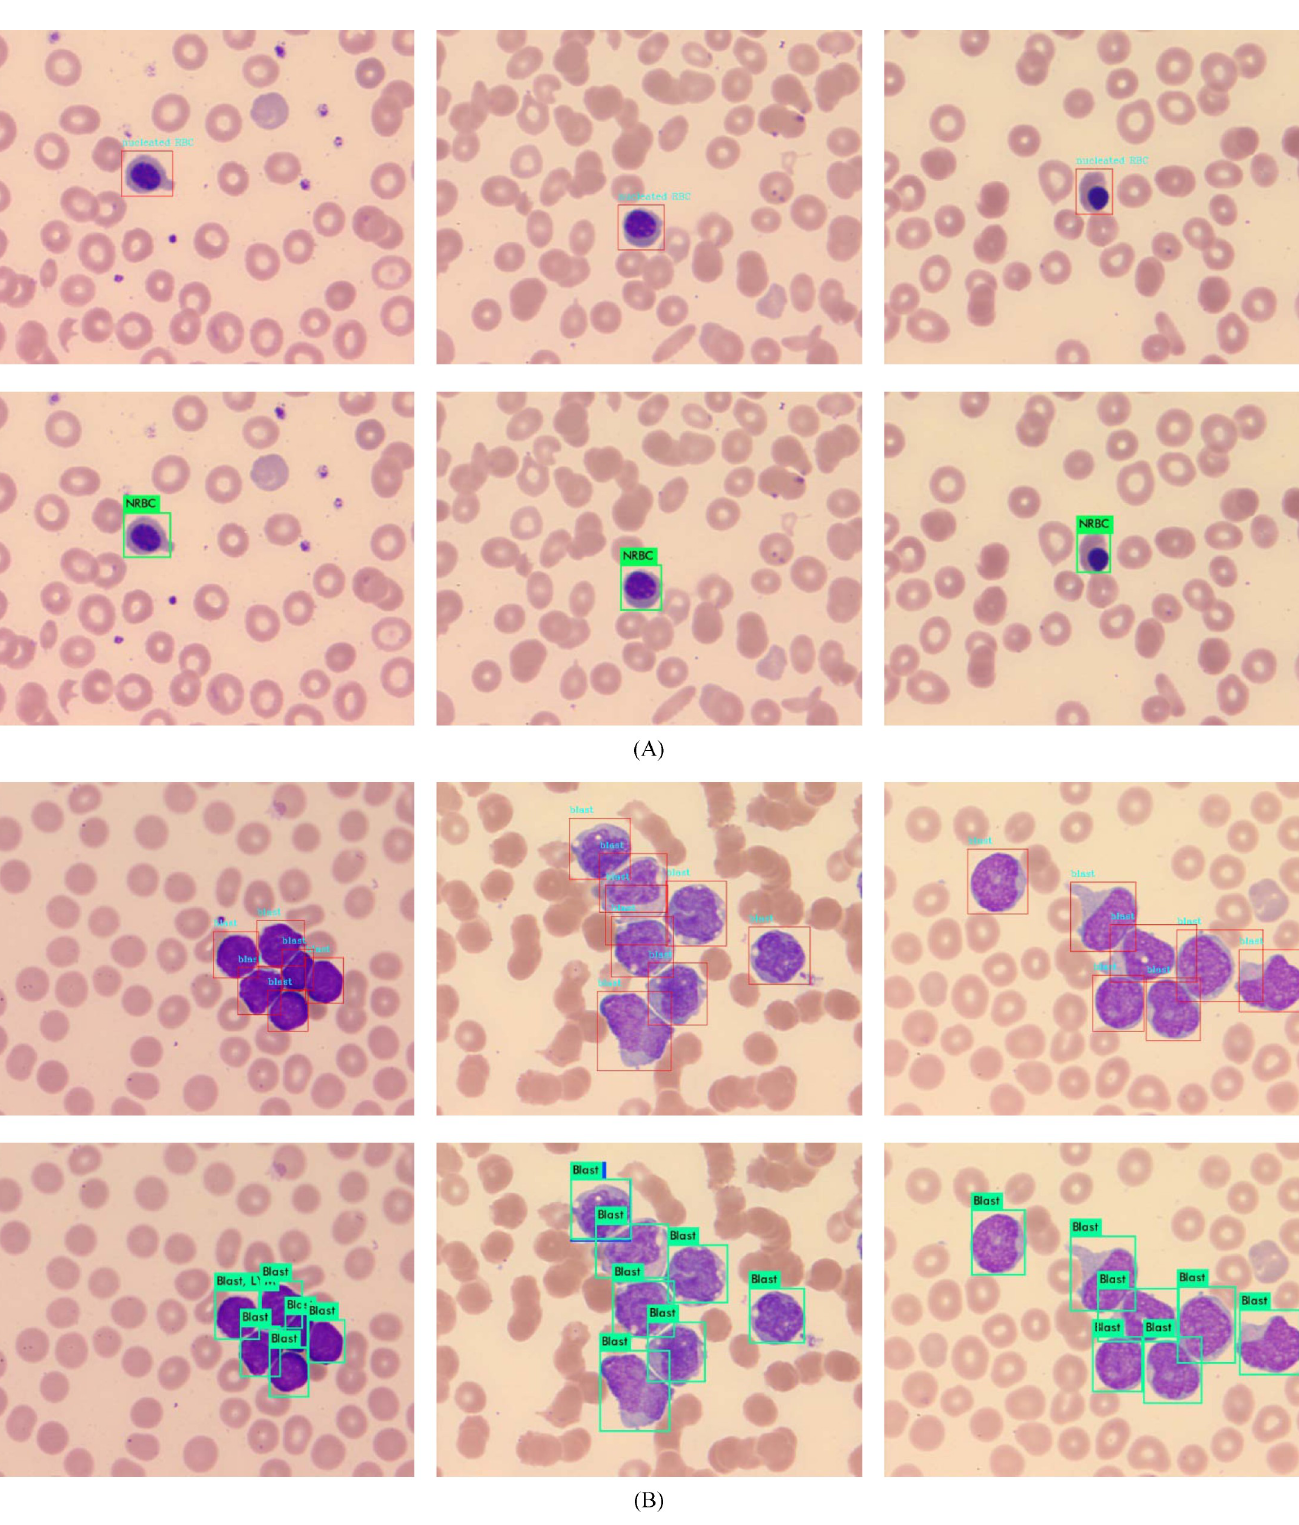
PLOS ONE | https://doi.org/10.1371/journal.pone.0218808 June 25,